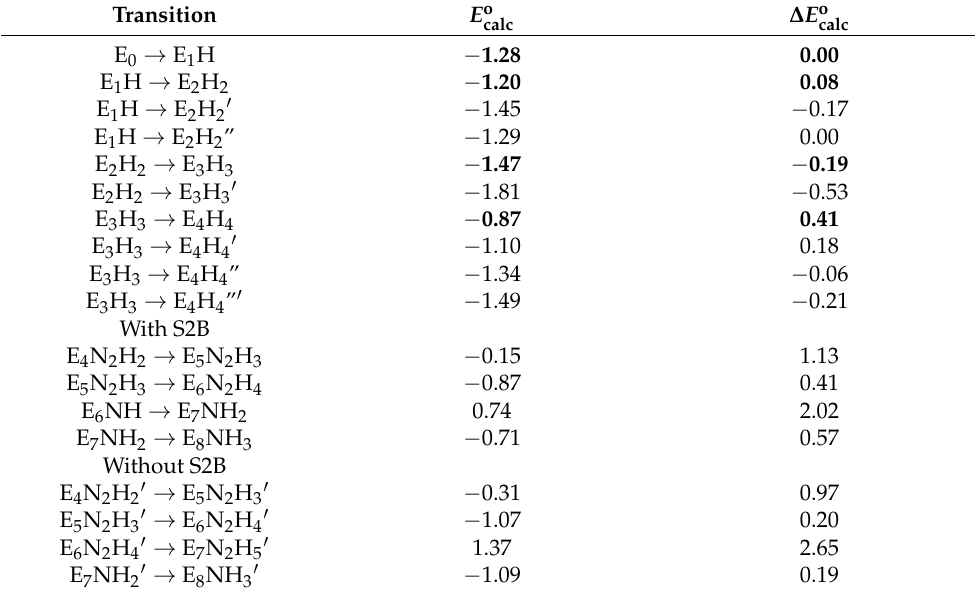
Table 6. Calculated redox potentials for the E 0 –E 8 states of the FeMo cluster. The last column ( ∆ E o reports the difference in the calculated redox potential compared to that of the E 0 → E 1 H transition. Redox potentials for the most favourable structures of the first four transitions are shown in bold